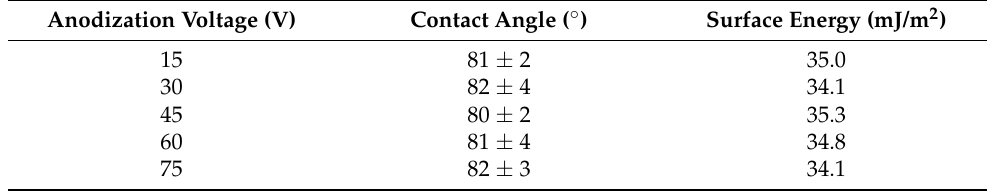
Table 2. Contact angle of anodically colored surfaces.